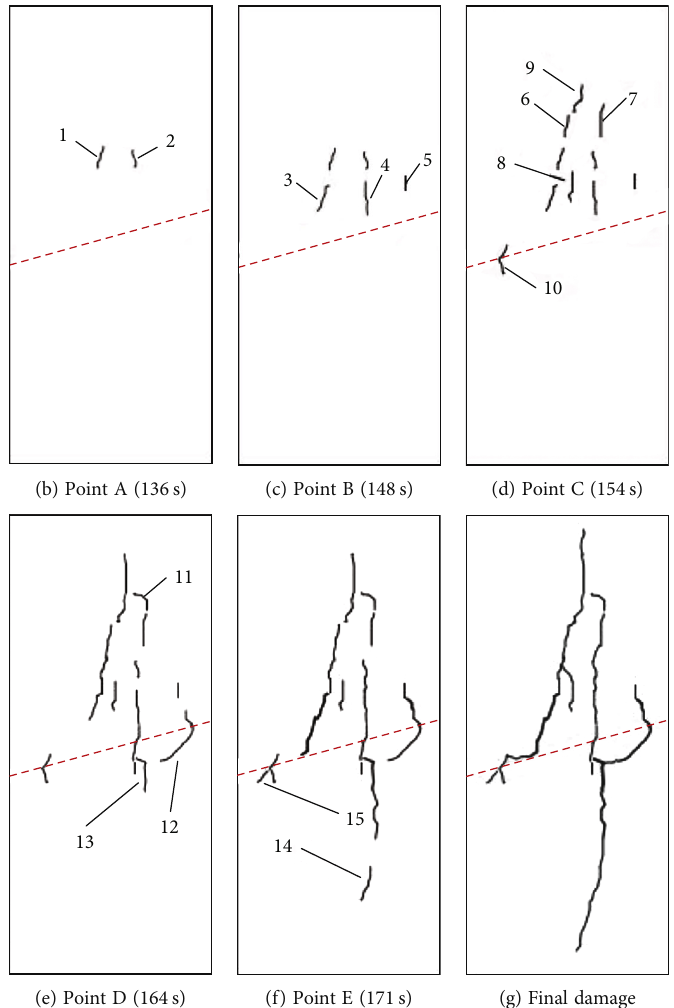
Figure 10: Grouted body specimen cracking extension process at a displacement rate of 0.03mm/s and a crack inclination angle of 30 °